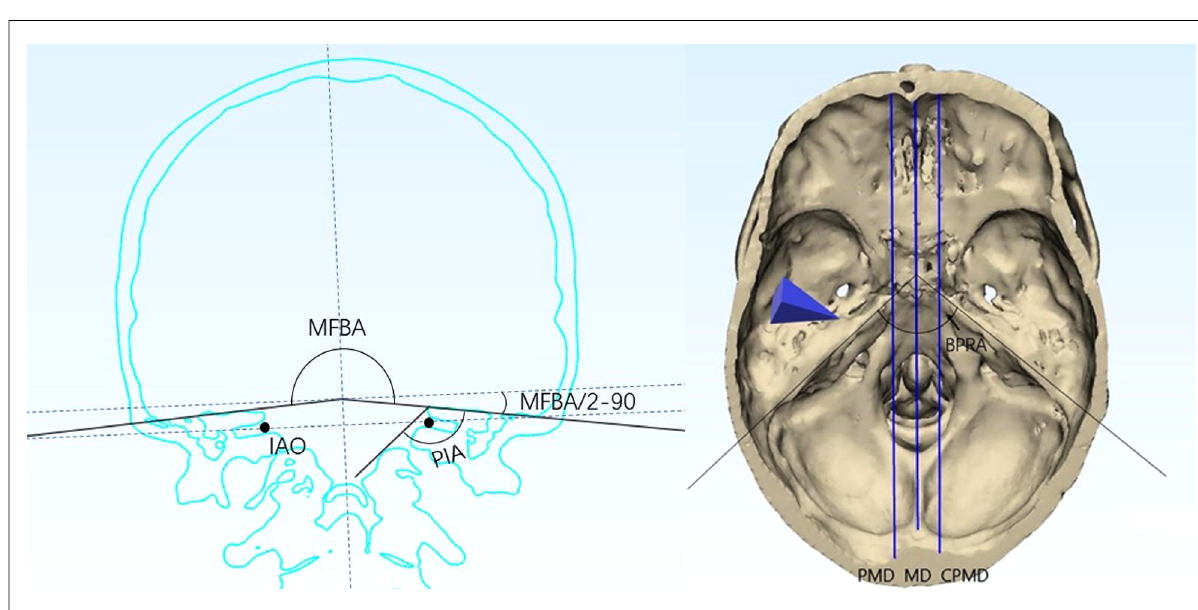
FIGURE 2 De fi nition of angles and lines set in the model: ( A ) MFBA and PIA; ( B ) BPRA, PMD, MD, and CPMD. BPRA, bilateral petrous ridge angle; PIA, petrous inner angle; MFBA, middle fossa bottom angle; MD, midline; PMD, para-middle line; CPMD, contralateral para-middle